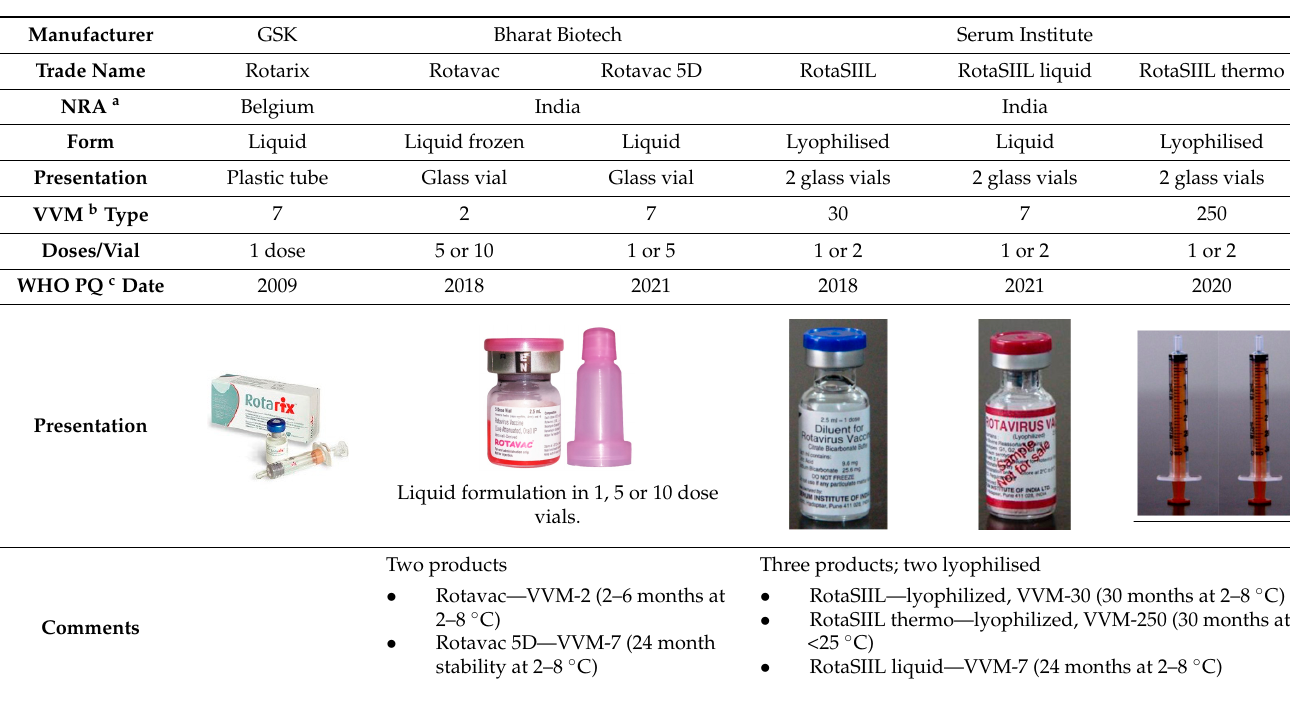
Table 1. WHO pre-qualified oral, live-attenuated rotavirus vaccines available for country implemen- tation (modified from reference